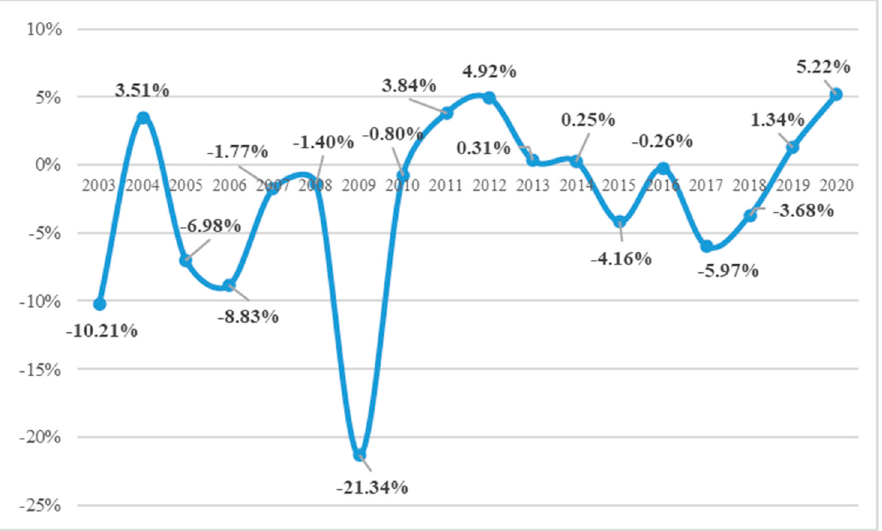
Figure 4. Ratio of the budget deficit/surplus to the annual budget revenues for 2003–2020 (in %) for the city of Ruda Ś l ą ska. Source: own elaboration.